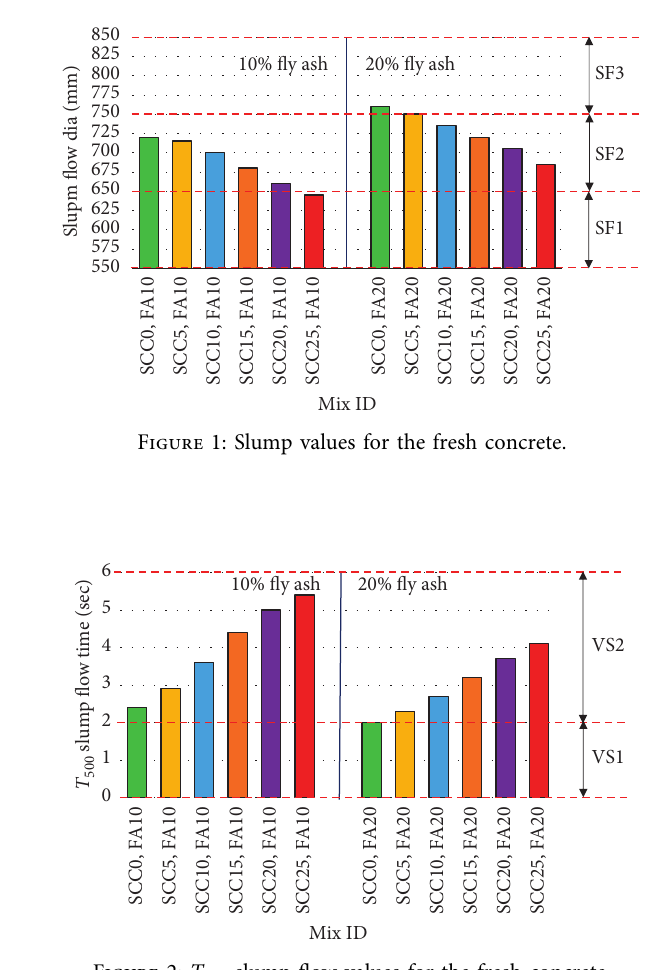
Figure 2: T 500 slump flow values for the fresh concrete.